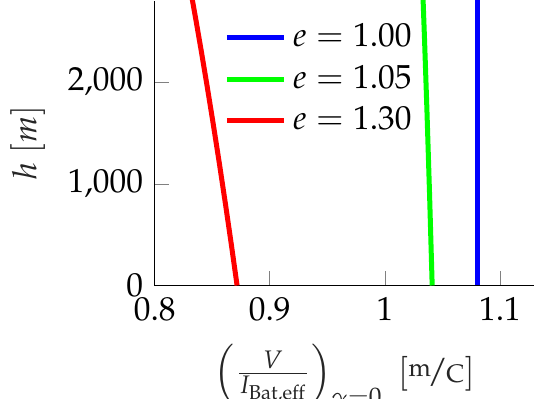
Figure 3. Values of the criterion for range optimal horizontal flight depicted over altitude h for e = [ 1.00,1.05,1.30 ]